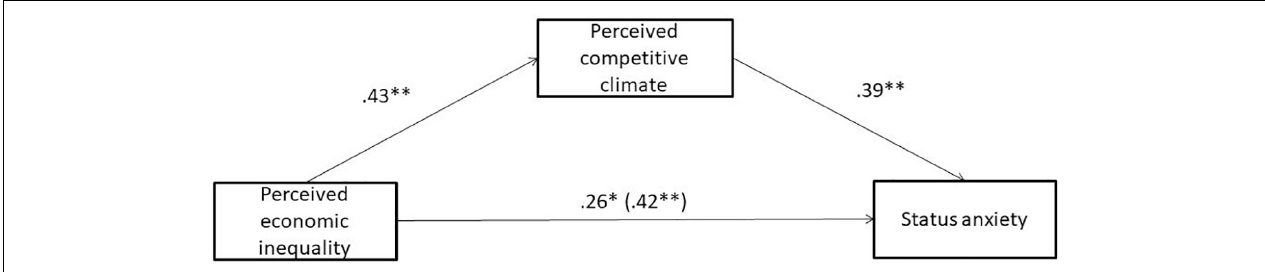
FIGURE 1 | Indirect effect of perceived economic inequality on status anxiety through perceived competitive climate in study 1. Coefficients are standardized; total effect in parenthesis; ∗ p < 0.01; ∗∗ p < 0.001.